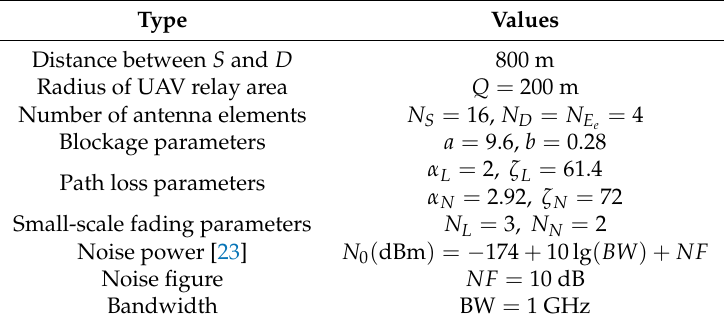
Table 2. Simulation